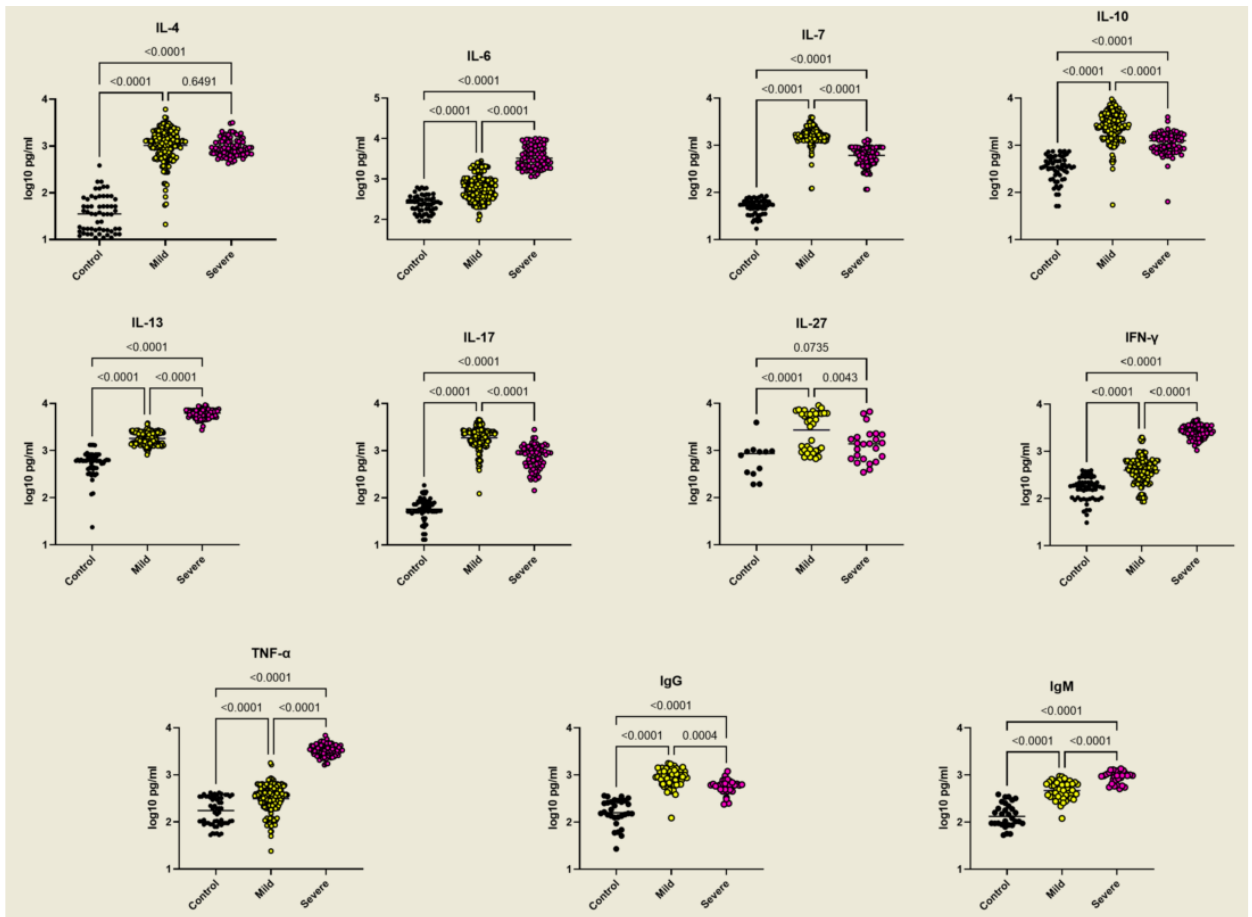
Figure 3. Cytokine and Immunoglobulin levels in mild and severe malaria patients and controls. A panel of control donors and mild or severe malaria patients was tested for the indicated cytokines, IgG, and IgM by using ELISA. Each dot corresponds to an individual patient. The significance of the differences was calculated by one-way ANOVA ( p ≤ 0.05, p ≤ 0.001, and p ≤ 0.0001).